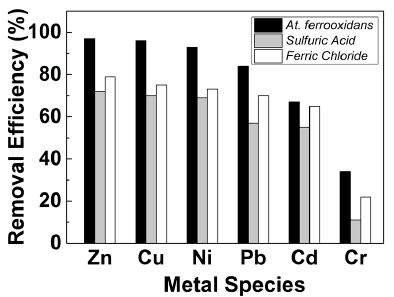
Figure 1. Metal removal efficiencies obtained by chemical (i.e., sulfuric or ferric chloride leaching) and bioleaching using A. ferrooxidans . The results were obtained at optimum operating conditions: pH, 2; pulp density, 2% ( w / v ); agitation speed, 120 rpm; and, temperature, 25 ± 2 °C. Data obtained from Bayat and Sari 2010 [22]. Table 1. Metal recoveries achieved using various microorganisms under different operating conditions. The table includes mesophilic and thermophilic species that thrive in different pH range solutions.